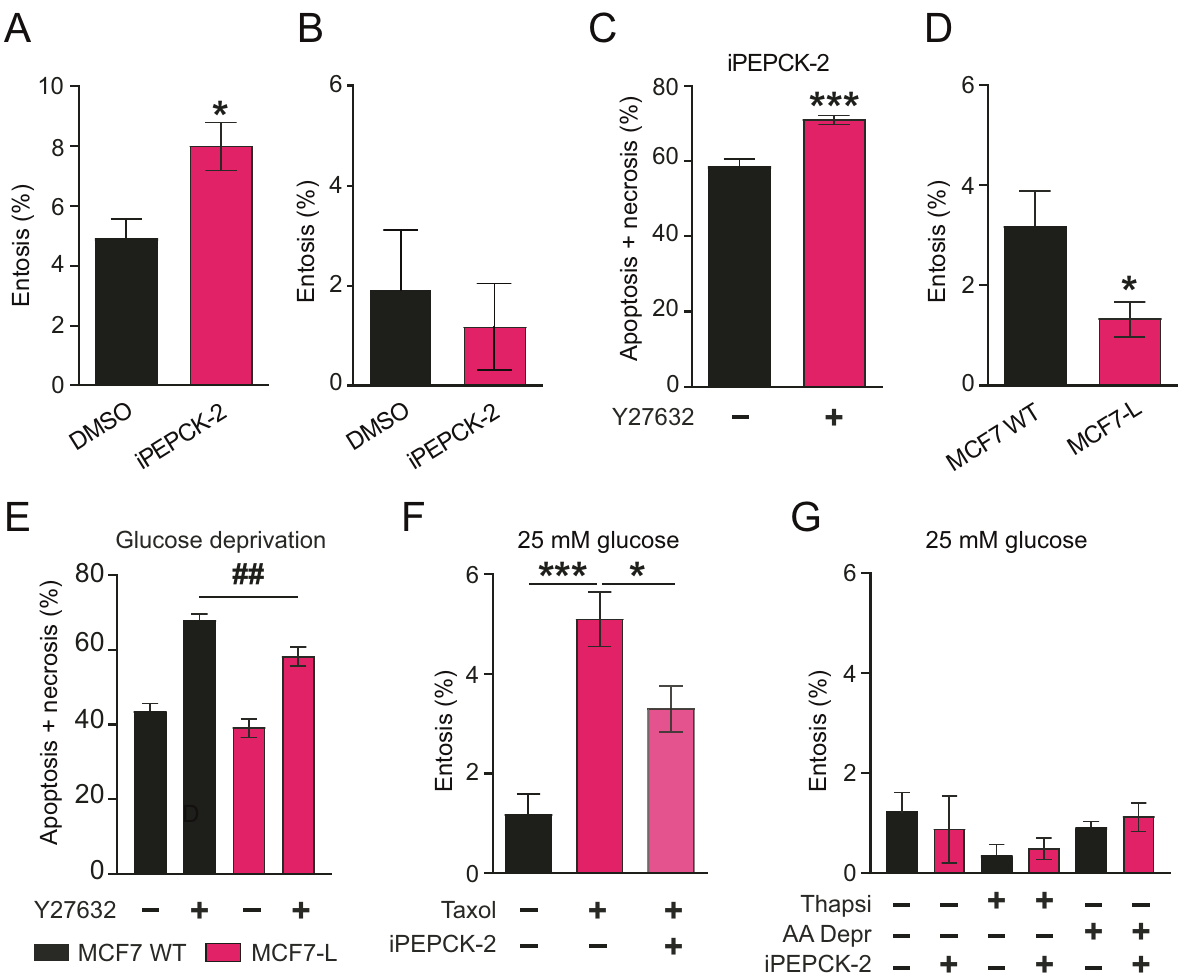
Fig. 3 Changes in the activity of the PEPCK-M pathway regulates entosis in the absence of glucose. A Percentage of entotic cells observed in wild-type MCF7 cells after 72 h of growth in 0 mM glucose media in the presence of iPEPCK-2 (5 µM) or vehicle (DMSO) (Two-tailed t -test; n = 5). B Percentage of entotic cells observed in wild-type MCF7 cells after 48 h of growth in 25 mM glucose media in the presence of iPEPCK-2 (5 µM) or vehicle (DMSO) (Two-tailed t -test; n = 3). C Percentage of apoptotic + necrotic cells wild-type MCF7 cells detected after 72 h of growth in 0 mM glucose media in the presence of iPEPCK-2 (5 µM), and Y27632 (10 µM) or vehicle (DMSO). Cells were analyzed by fl ow cytometry using Annexin V-APC and SYTOX ™ Green Nucleic Acid Stain Statistical analysis queried Y27632 versus DMSO in the presence of iPEPCK-2 (Two-tailed t -test; n = 6). D Percentage of entotic cells observed in wild-type MCF7 cells and in MCF7 cells overexpressing PEPCK-M (L-PCK2) at the 72 h time point of growth in 0 mM glucose media (Two-tailed t -test; n = 4). E Percentage of apoptotic + necrotic cells wild-type MCF7 and in MCF7 cells overexpressing PEPCK-M (L-PCK2) cells detected after 72 h of growth in 0 mM glucose media in the presence of Y27632 (10 µM) or vehicle (DMSO). Cells were analyzed by fl ow cytometry using Annexin V-APC and SYTOX ™ Green Nucleic Acid Stain Statistical analysis queried MCF7-L versus MCF7 WT ( # One-way ANOVA with Newman – Keuls post-hoc test; n = 8) or Y27632 versus DMSO (*Two-tailed t -test; n = 8). F Percentage of entotic cells observed in wild-type MCF7 cells detected after 24 h of growth in 25 mM glucose media with taxol (1 µM) in the presence of iPEPCK-2 (5 µM) or vehicle (DMSO) (Two-tailed t -test; n = 4). G Percentage of entosis in wild-type MCF7 cells grown in 25 mM glucose media in the presence of thapsigargin (100 nM; 24 h) and amino-acid limitation media (DMEM w/o serine, glycine, arginine and leucine; 48 h). Additionally, cells were treated with iPEPCK-2 (5 µM) or vehicle (DMSO). Statistical analysis queried iPEPCK- 2 versus DMSO for each independent treatment; Thapsi and AA Depr (Two-tailed t -test; n = entosis, PCK2 is overexpressed in breast carcinoma (Fig. 5A, B). In (Fig. 4E; left panel). The relative amount of intermediate, smeared the mammary gland, as in the liver, we observed a switch from bands for speci fi c membrane protein markers such as LAMP1 was PCK1 to PCK2 isoforms going from differentiated tissue to increased in the presence of iPEPCK-2, indicating defects in malignant cells [11]. We then examined the distribution of both glycosylation resulting in the appearance of partially glycosylated molecular subtypes and 3-gene classi fi er signatures in high and low peptides are modulated by PEPCK-M activity (Fig. 4E; right panel). PCK2 expressing tumor samples from breast cancer patients curated in the Metabric dataset [15]. In this analysis, high PCK2 PEPCK-M is enriched in breast tumors of epithelial origin expression samples were enriched in ER + and ER + /Her2- High Entosis is restricted to the epithelial, E-cadherin (CDH1) enriched proliferation subtypes, which also correlated with lower Basal and phenotype [10], therefore, a switch to N-cadherin (CDH2) char- higher Luminal B/Her2 frequencies (Fig. 5C). Consistently, PCK2 is acteristic of the epithelial-mesenchymal transition would impede preferentially enriched in specimens expressing epithelial markers the process. Consistent with a role in cancer metabolism and in